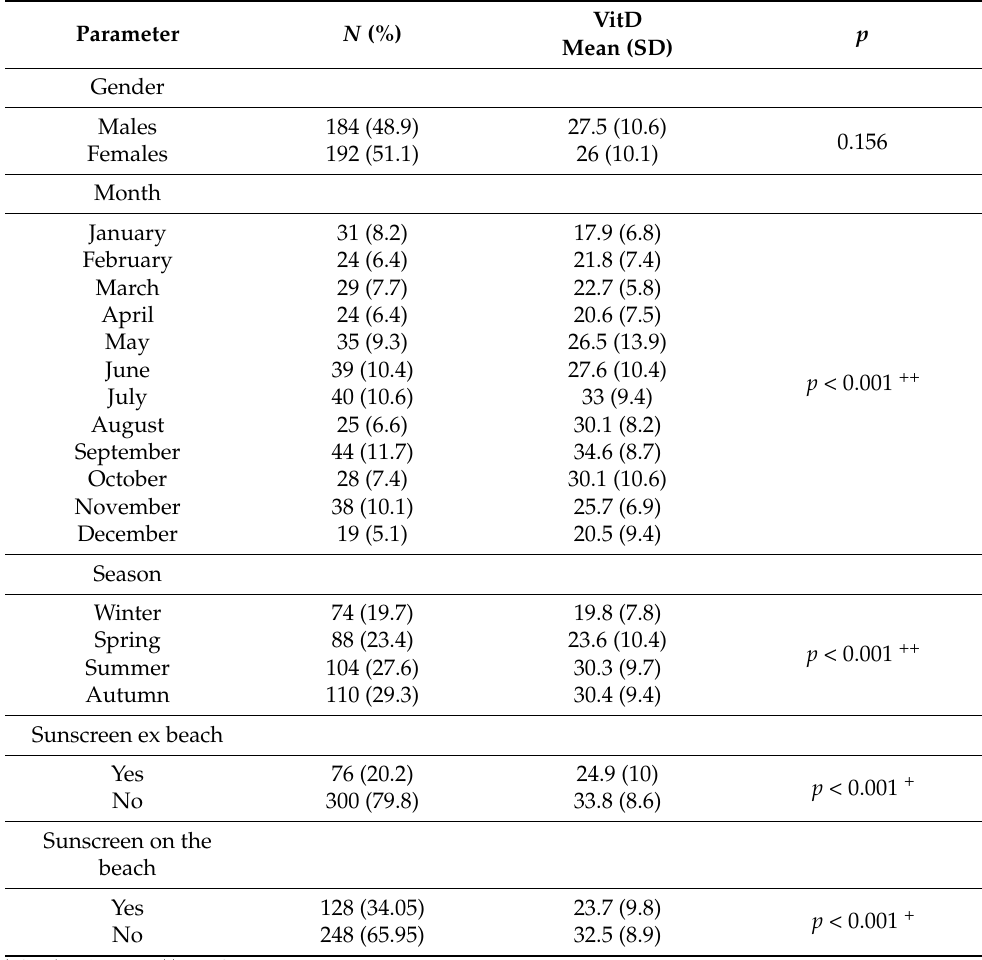
Table 1. Demographic data and vitamin D level according to patient gender, season, and use of